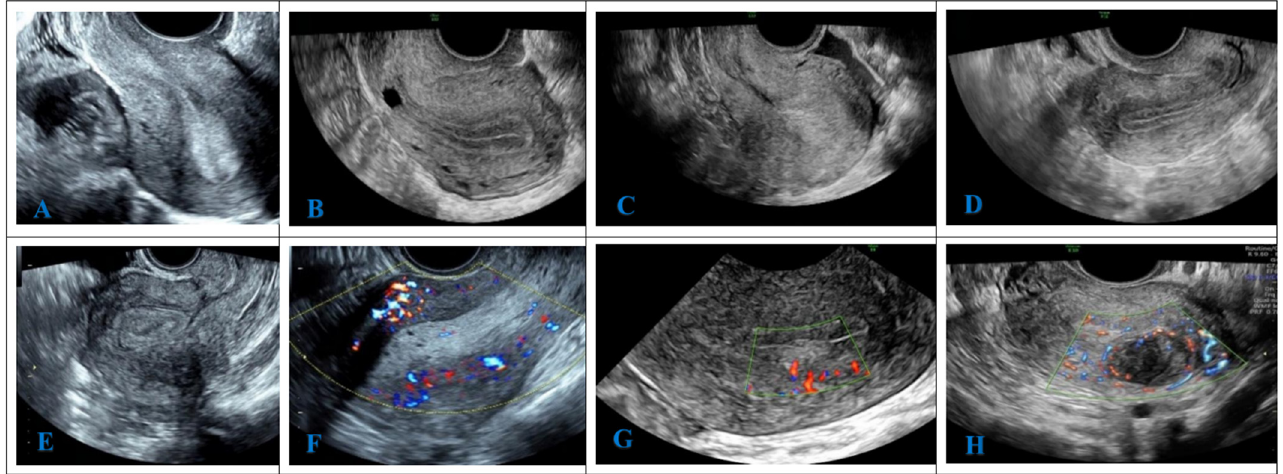
Figure 1. Images of benign IETA ultrasonographic features. ( A ) Homogeneous hyperechoic; ( B ) Three-layer pattern; ( C ) Homogeneous isoechoic; ( D ) Endometrial midline appearance: “linear” and endometrial–myometrial junction: “regular”; ( E ) The “bright edge” sign, the echo formed by the interface between an intracavitary lesion and the endometrium; ( F ) Homogeneous with regular cysts; ( G ) Vascular pattern: single vessel (without branching); ( H ) Vascular pattern: circular vessels.